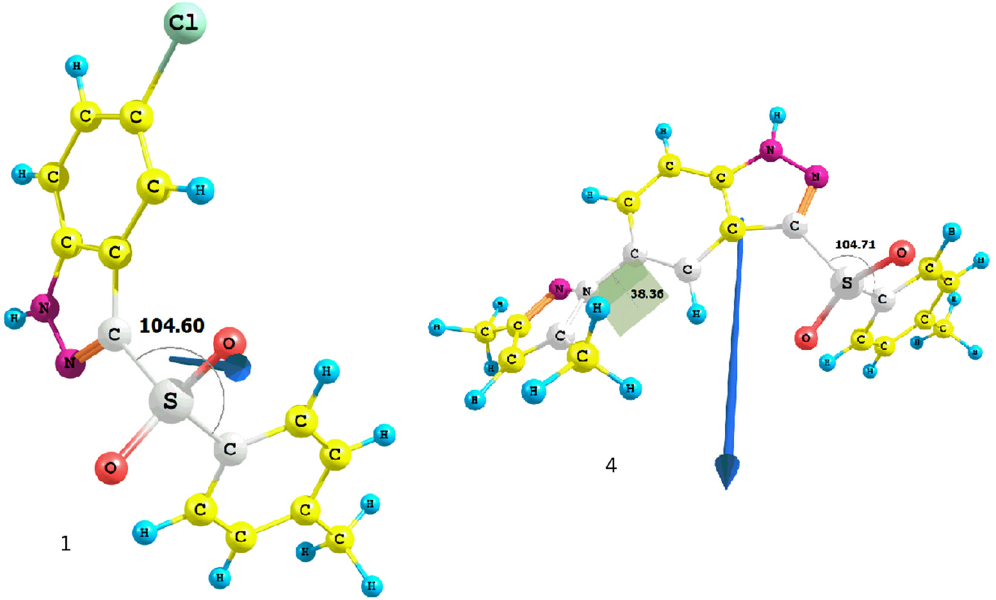
Figure 2: Visualisation of the dipole moment of azoles 1 and 4 ( B3LYP/6 - 311 ++ G ( 2d,3p ) //B3LYP - 631G ( d,p ) ; gaseous phase ) . The atoms forming the dihedral angles are marked in light grey colour; the molecular dipole moment is shown with the blue